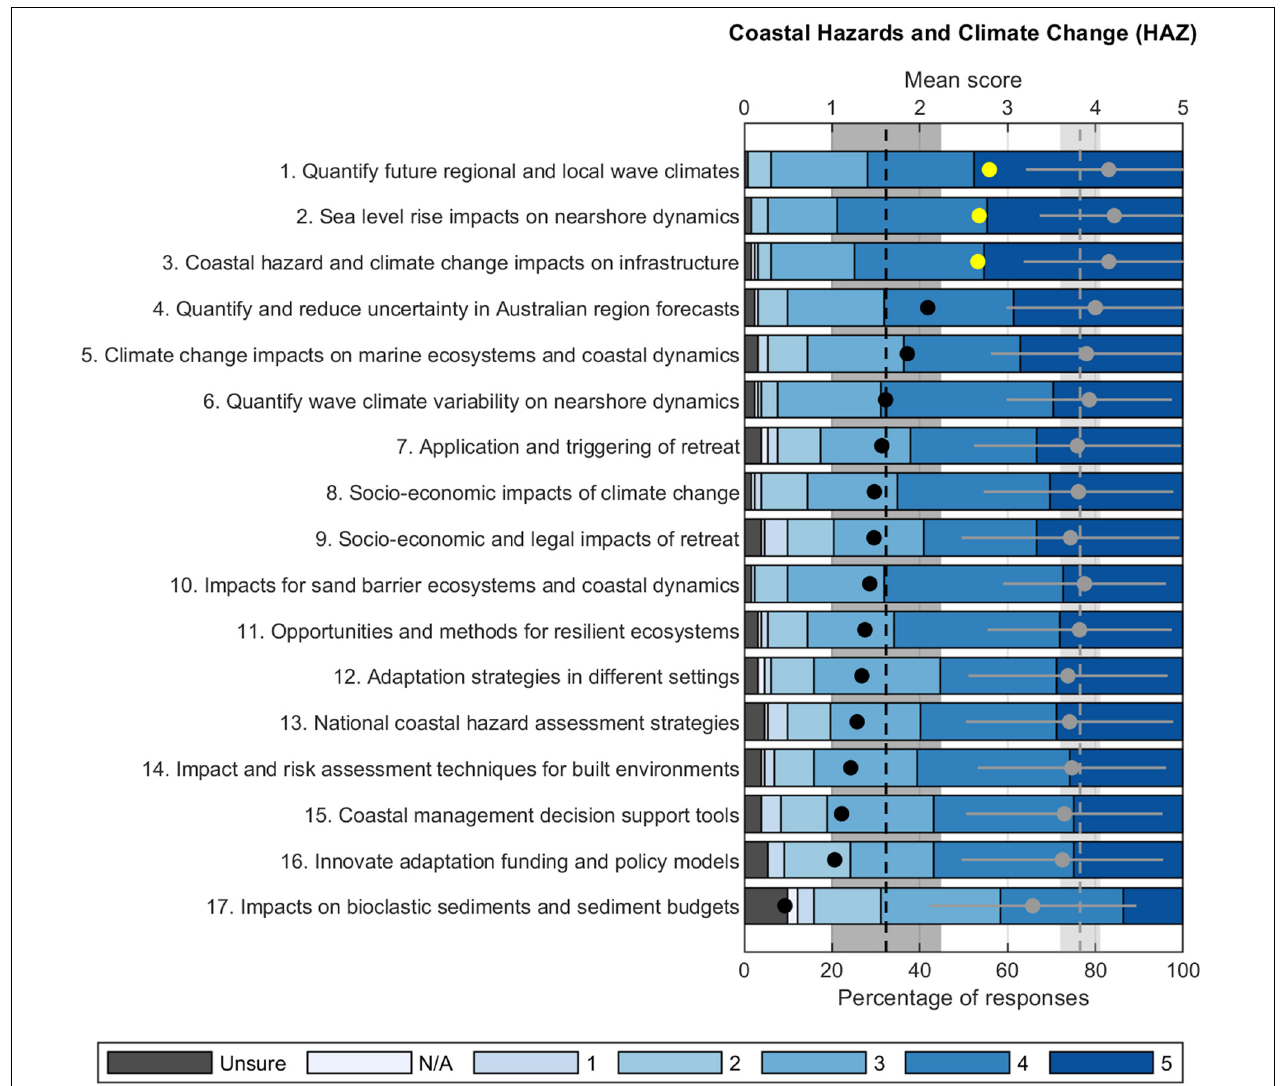
FIGURE 8 | Stacked bar plot showing the distribution of Stage 3 respondent scores for priorities in the Coastal Hazards and Climate Change (HAZ) category. See Figure 5 for full